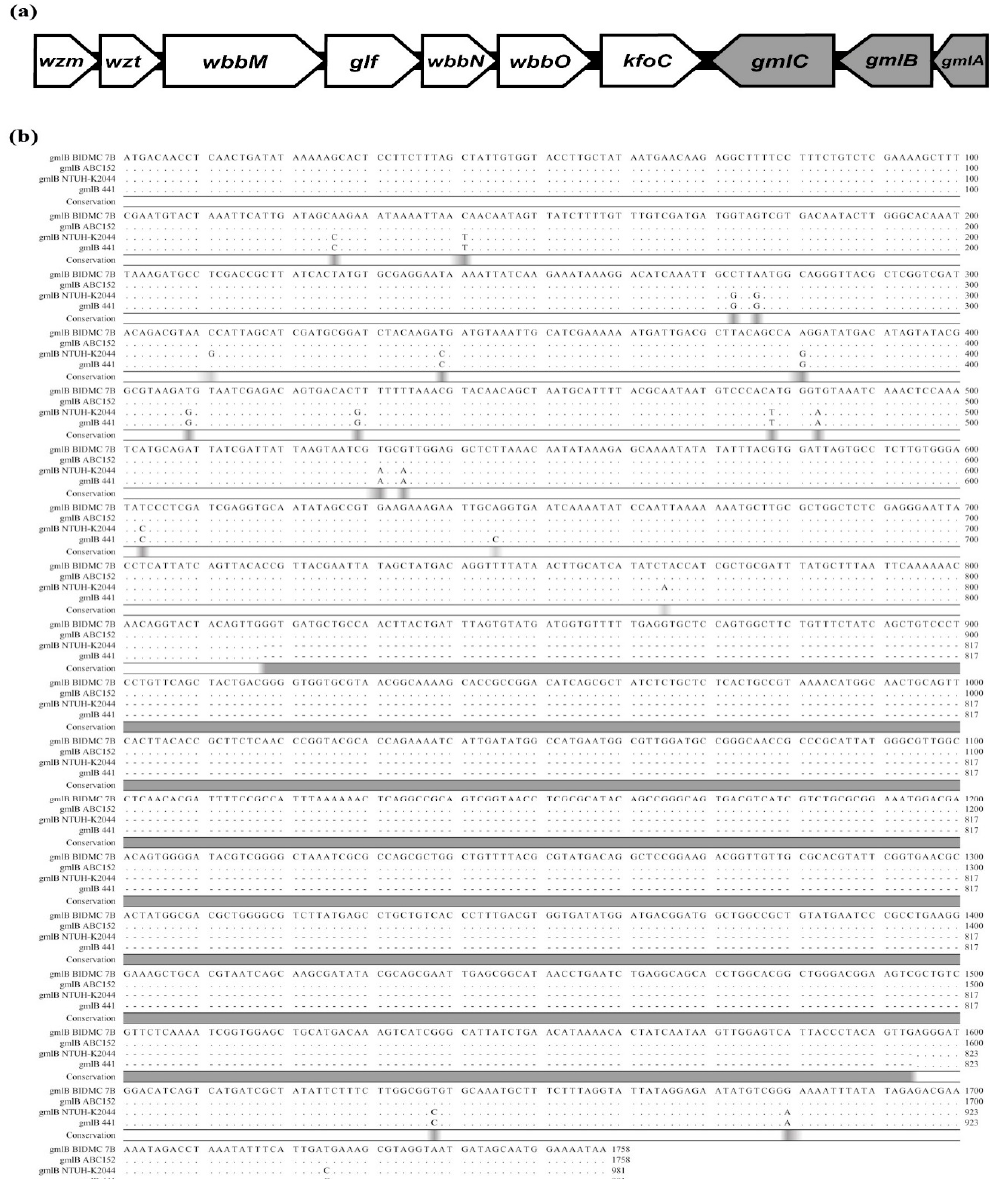
Figure 1. Organization and comparative analysis of rfb gene clusters: ( a ) Organization of the rfb cluster of K. pneumoniae O1 / O2 variant 2. The wzm and wzt genes encode transmembrane and nucleotide-binding domains of an ABC transporter. The wbbMNO genes encode glycosyltransferases. The glf gene encodes UDP-galactopyranose mutase. The function of kfoC is unknown. The gml genes (highlighted in grey) encode the structural modification of D-galactan I; and ( b ) alignment of the gmlB genes of K. pneumoniae BIDMC 7B, ABC152, and two reference strains with gmlABC locus (NTUH-K2044 and 441). Grey areas mark regions of differences in nucleotide sequence. The alignment was performed using the CLC Main Workbench.